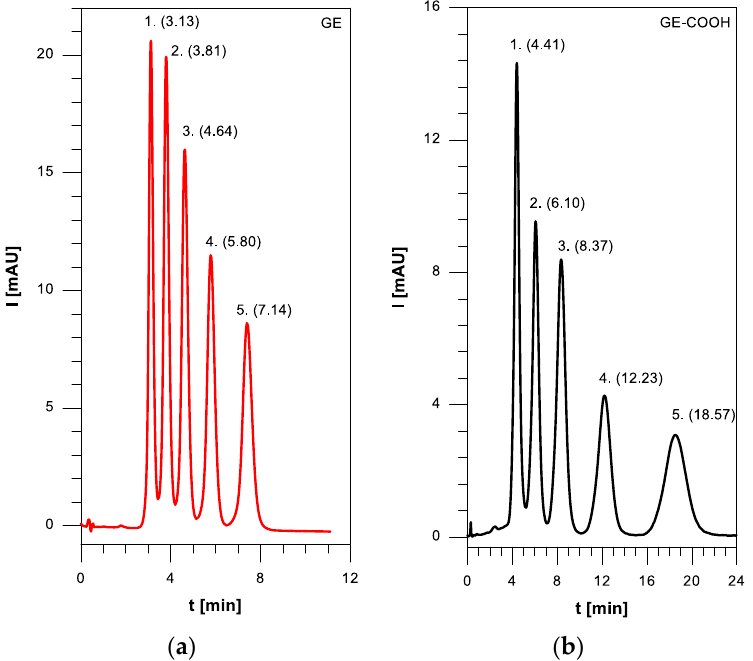
Figure 6. Separation of the mixture of homologous alkyl benzenes, ACN-buffer: ( a ) GE; ( b ) GE-